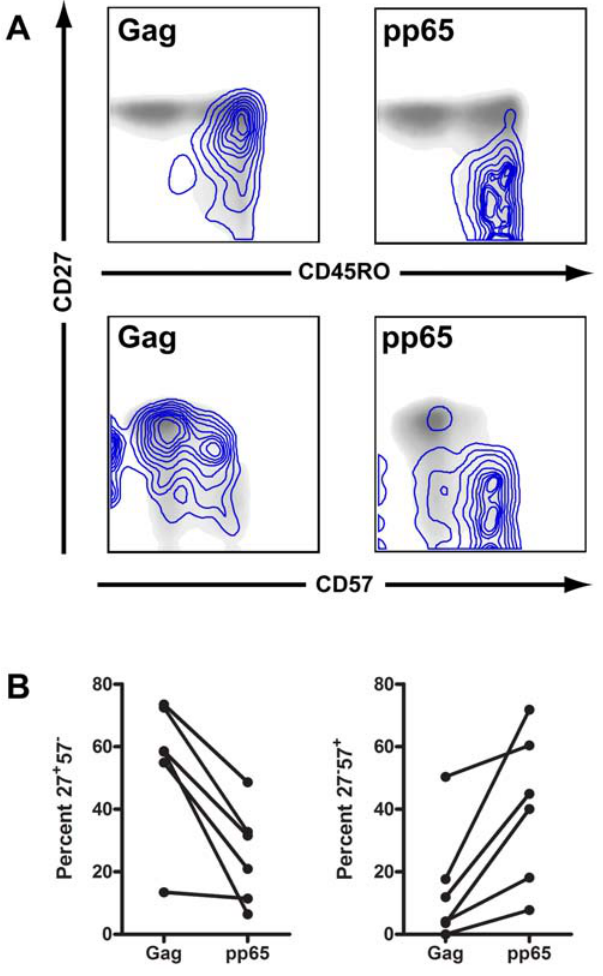
Figure 2. pp65-specific CD4 + T cells are more mature than Gag- specific CD4 + T cells. A) Gag-specific and pp65-specific CD4 + T cells, shown by blue isobars, are overlaid onto 2 dimensional density plots for total CD4 + T cells plotted against CD27 and CD45RO or CD27 and CD57 surface expression. B) For each of the 6 individuals characterized gag- specific CD4 + T cells had higher CD27 expression and lower CD57 responses than did pp65-specific CD4 + T cells ( P , 0.05).